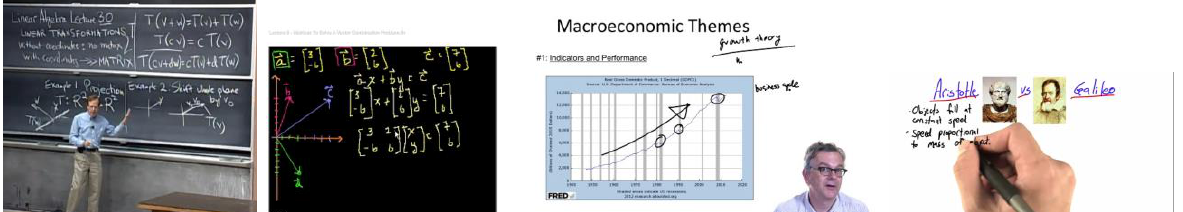
Figure 1. The presentation format of instructional videos ranges from direct recording of classroom teaching with a stationary camera, or writing board screencasts with voice-over, to highly elaborate video post-production with picture-in-picture, or video blending techniques (from left to right: MIT OpenCourseware, Khan Academy, Coursera,